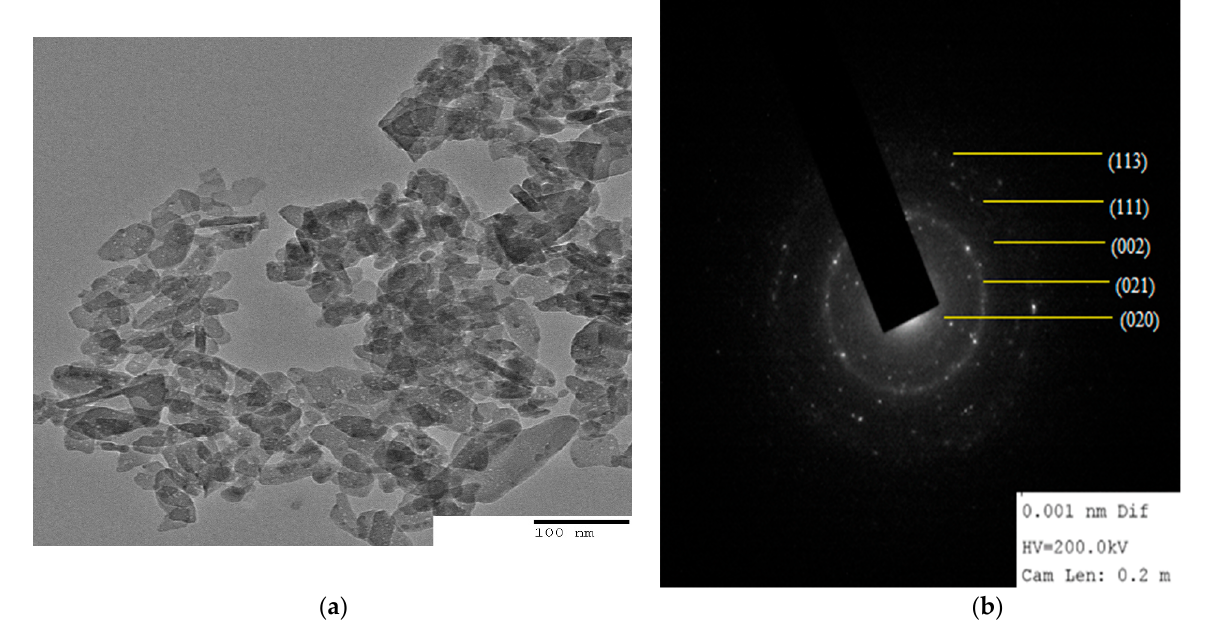
Figure 5. ( a ) TEM image of CuO/Alg-Agar BNC showing distribution of CuO NRs on the Figure 4. ( a ) TEM image of CuO/Alg-Agar BNC showing distribution of CuO NRs on the biopolymer biopolymer matrix of AA-Alg and ( b ) SAED image of CuO/Alg-Agar BNC. matrix of AA-Alg and ( b ) SAED image of CuO/Alg-Agar BNC.